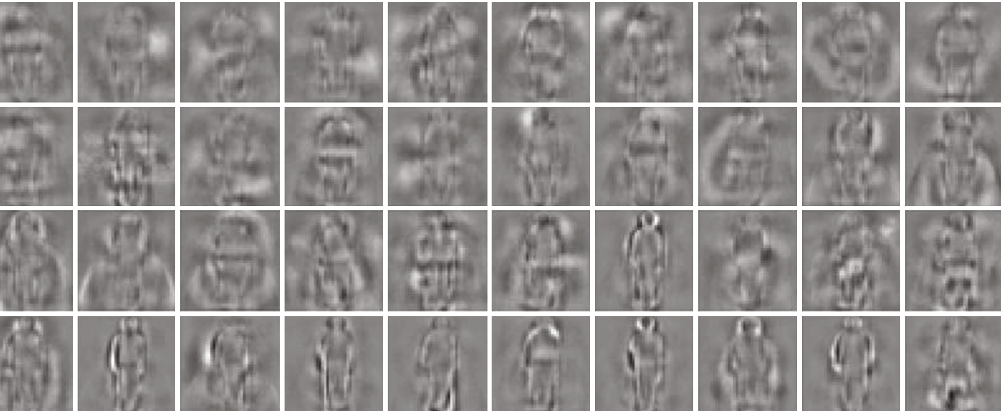
Figure 8: The bases of image set.